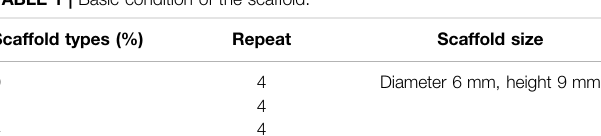
TABLE 1 | Basic condition of the scaffold.